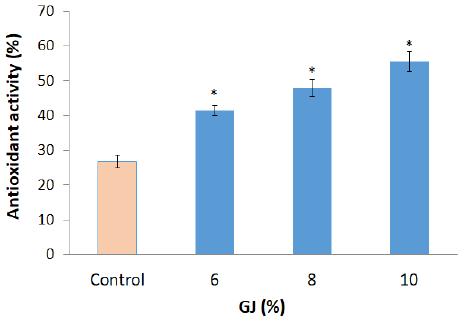
Figure 3. Effects of different concentrations of grape juice (GJ) on the DPPH scavenging activity of obtained NS PC edible films, control was the NS PC film obtained with 30% glycerol at the same pH value 12. Values with (*) were significantly different compared with the control.